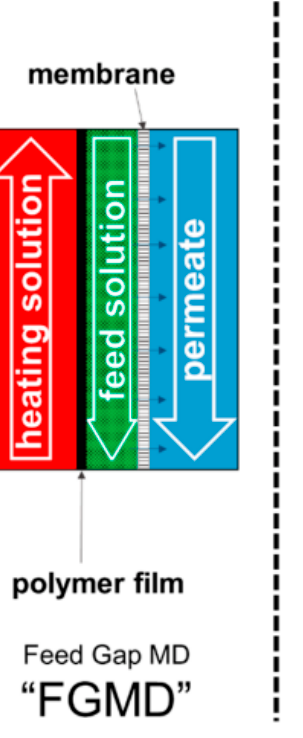
Figure 4. FGMD and FGAGMD configurations [15] .